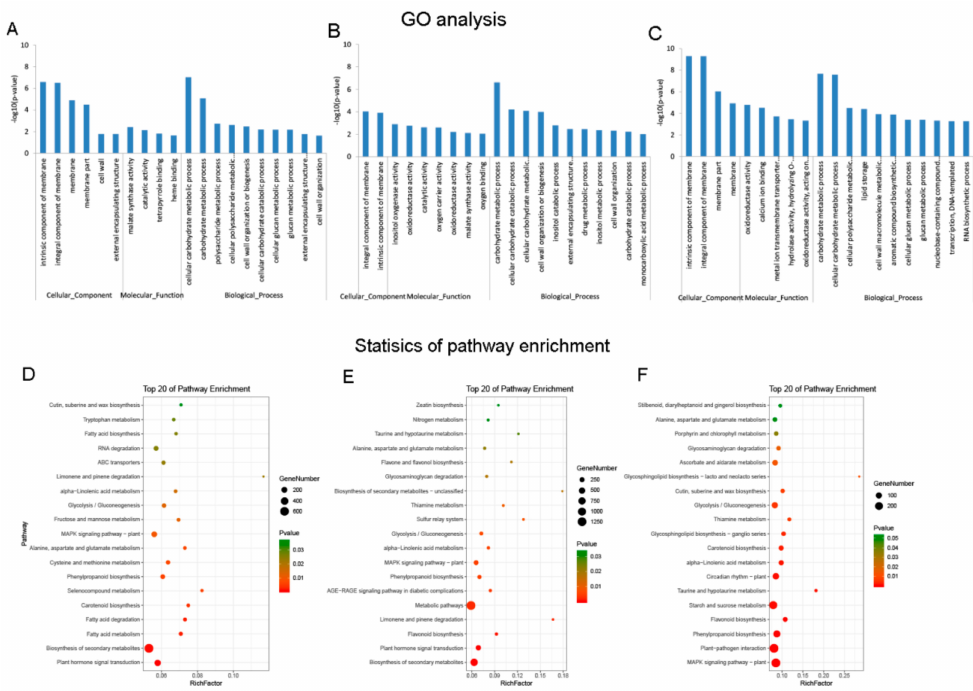
Figure 3. Di ff erential expression of mRNAs at three stages of anther development, between the cytoplasmic male sterility line C2P5A and the maintainer line C2P5B. Gene ontology (GO) analysis of DEGs in ( A ) MSPms-VS-MPms, ( B ) MSTds-VS-MTds, and ( C ) MSMs-VS-MMs. Statistical KEGG enrichment of DEGs in ( D ) MSPms-VS-MPms, ( E ) MSTds-VS-MTds, and ( F ) MSMs-VS-MMs. The dot size indicates the number of enriched di ff erentially expressed genes in each pathway, and the di ff erent color of the dot represents the p -value of each pathway. The top 20 enriched GO terms and KEGG enrichments ranked by p -values are shown. MS—Male sterile line; M—Maintainer line; Pms—pollen mother cell stage; Tds—tetrad stage; Ms—mononuclear